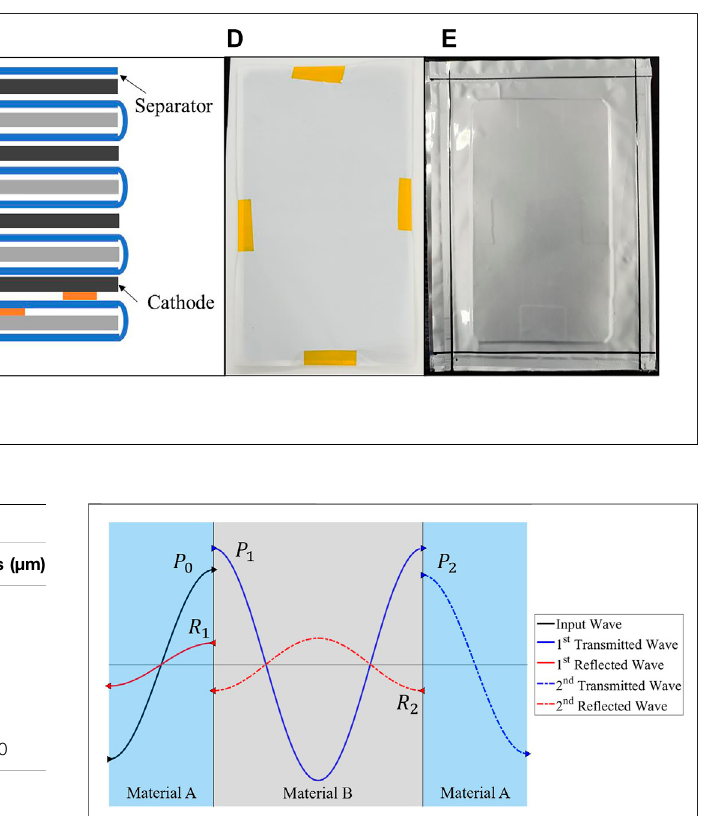
FIGURE 2 | Principles of sound wave transmission and re fl ection in multilayer